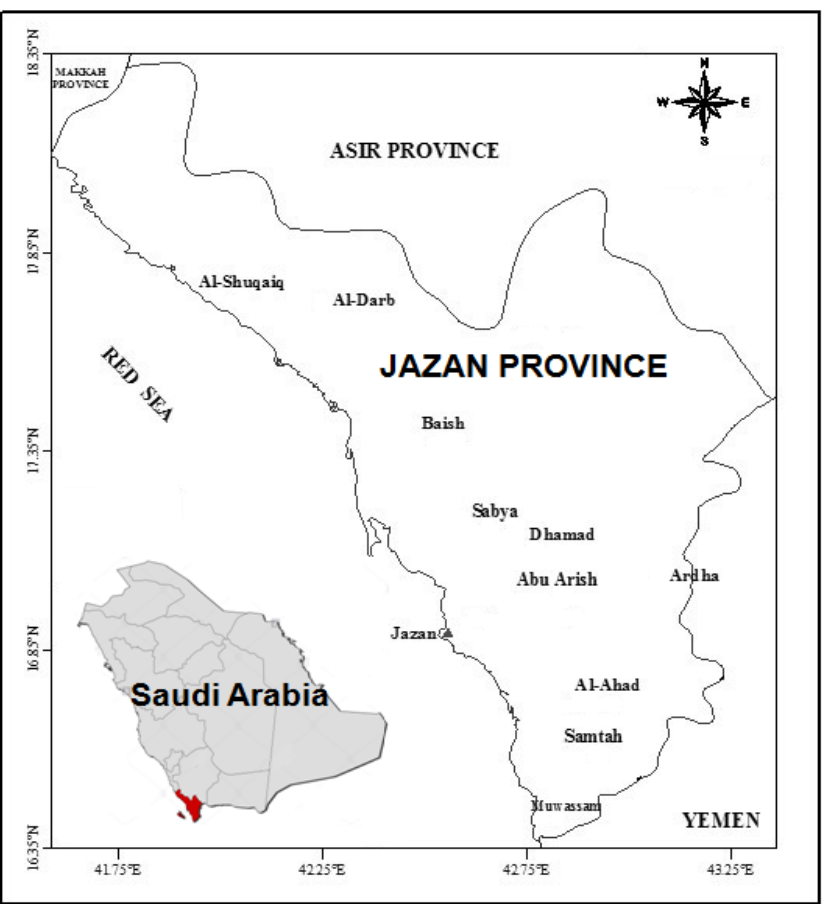
Figure 1. The map displaying Jazan province situated along the coast of the Red Sea in the southern region of Saudi Arabia.